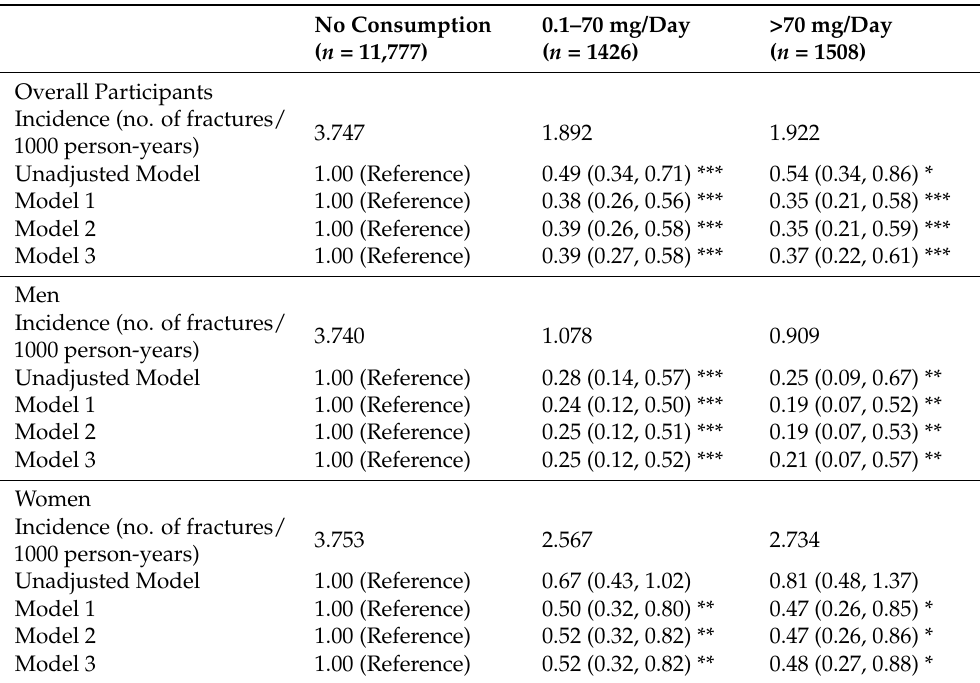
Table 3. Associations between calcium in dairy product intake and the risk of fracture.